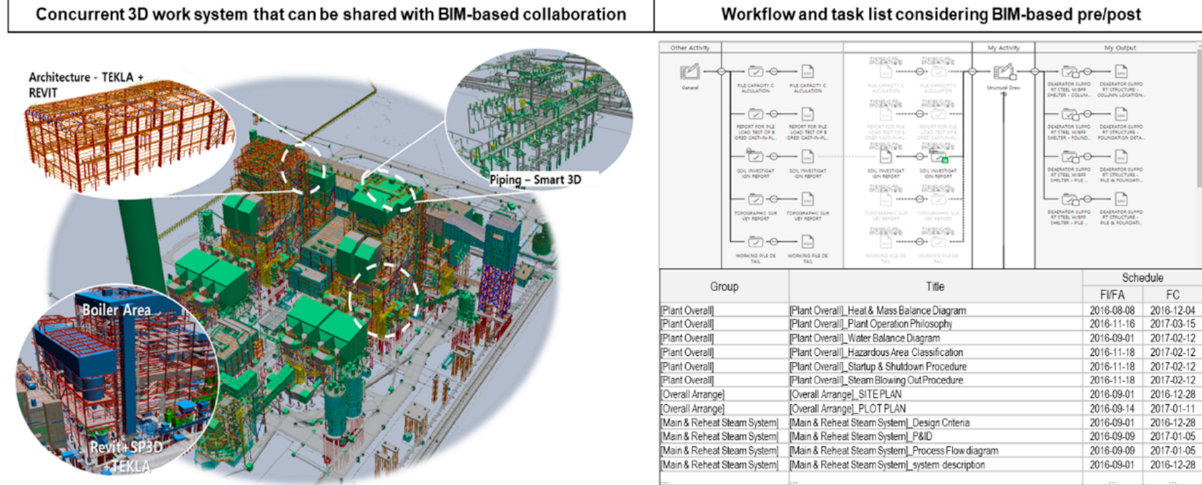
Figure 2. Case study: BIM-based FAB construction projects (adapted from